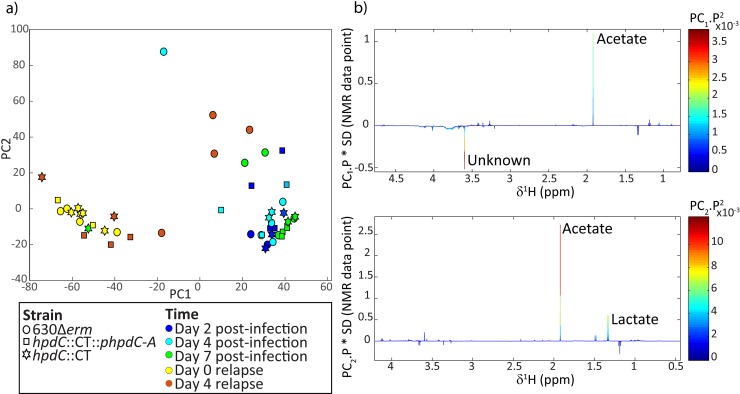
Metabolic profiling of the in vivo mouse relapse model of CDI.1H NMR spectroscopy was used to investigate metabolic differences between the individually caged mice infected with C. difficile strain 630Δerm, hpdC::CT or uninfected naïve mice. a) Principle component analysis of the metabolite diversity. Each dot represents a single sample at a given time point. A symbol code was used for the strains 630Δerm (circle), hpdC::CT (square) and naïve mice (star), and a colour code was used to represent the different time points, Day 2 post-infection (dark blue), Day 4 post-infection (light blue), Day 7 post-infection (green), Day 0 relapse (yellow) and Day 4 relapse (orange). b) Loading plots of the PCA model, representing the metabolites driving the distribution of the samples along principal component 1 (PC 1) and principal component 2 (PC 2).